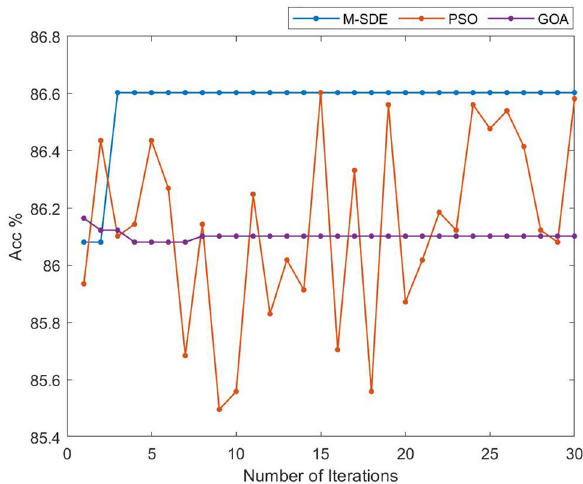
Figure 8. Comparison of iteration and accuracy of three methods.